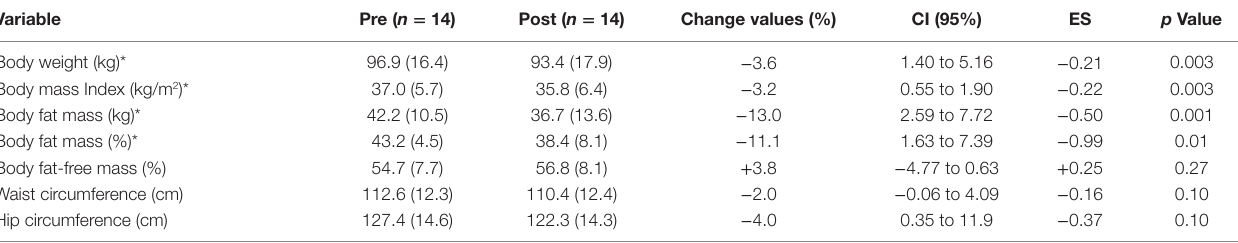
Data are expressed as means (SD), percent change, 95% confidence interval (CI) of the differences, and effect sizes (ES). Paired Student’s T tests were used to assess possible differences between time points. *Indicate which findings are statistically significant. Significance defined as p ≤